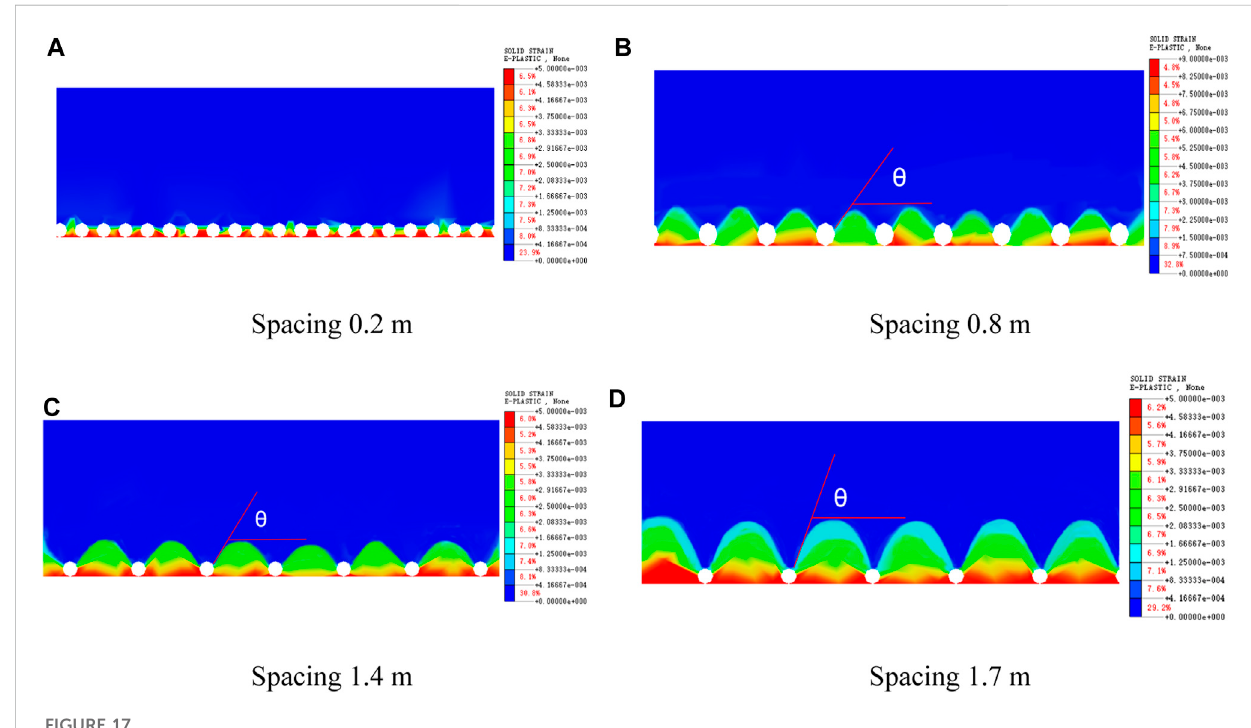
FIGURE 17 Soil plastic zone diagram for different pipe